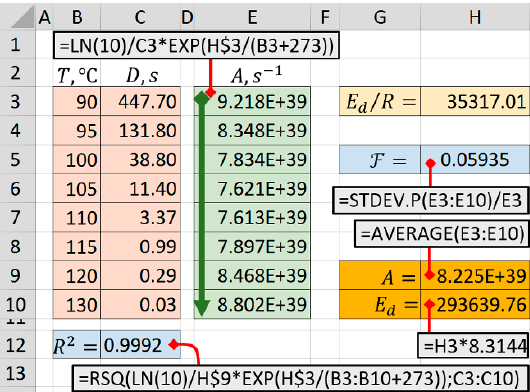
Figure 4. Excel worksheet of the identification of the kinetic parameters of the model.